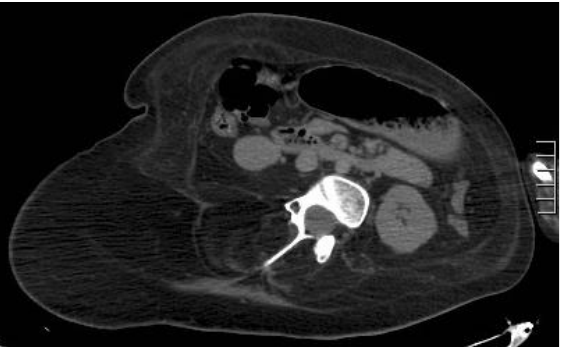
Figure 7. A 23-year-old patient with Duchenne’s syndrome. Axial, not-enhanced CT scan demon- strates complete fat replacement of all abdominal wall muscles with obligated decubitus, as com- monly seen in cases of Duchenne’s syndrome patients reaching the ages of 20 – 30.